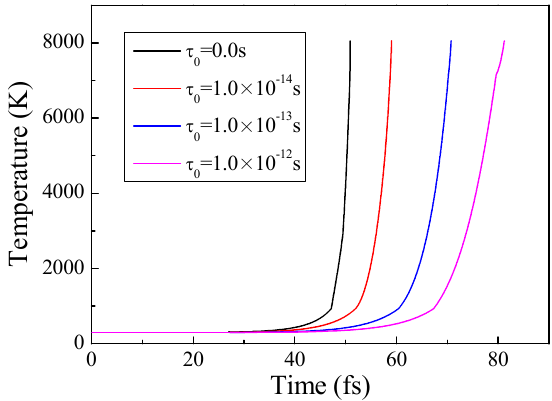
Figure 4. The temperature variation in the surface layer of target at different relaxation time ( F fluence = 10 J/cm 2 ).